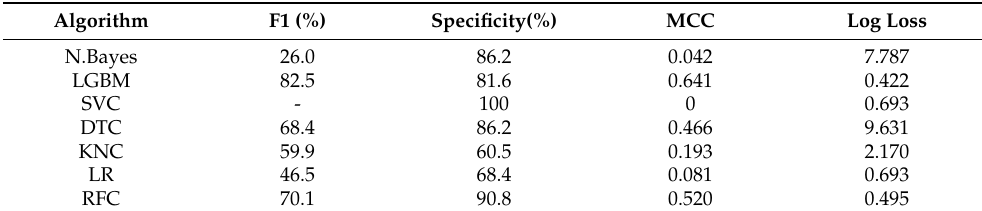
Table 9. The obtained other performance metrics results using the first eight channels EEG signals with machine learning classification algorithms.